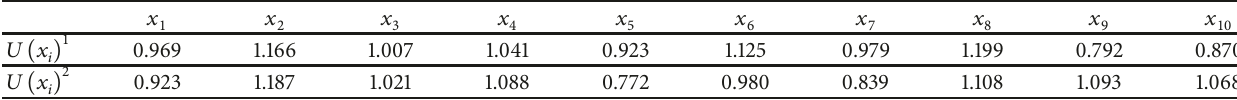
Table 8: The utility of the alternatives 𝑥 𝑖 under the different